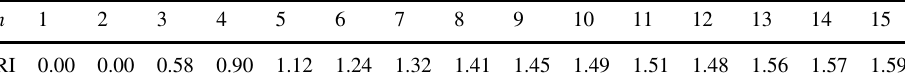
Table 3 RI values depending on criteria numbers ( n = 1–15) (Saaty 1990)